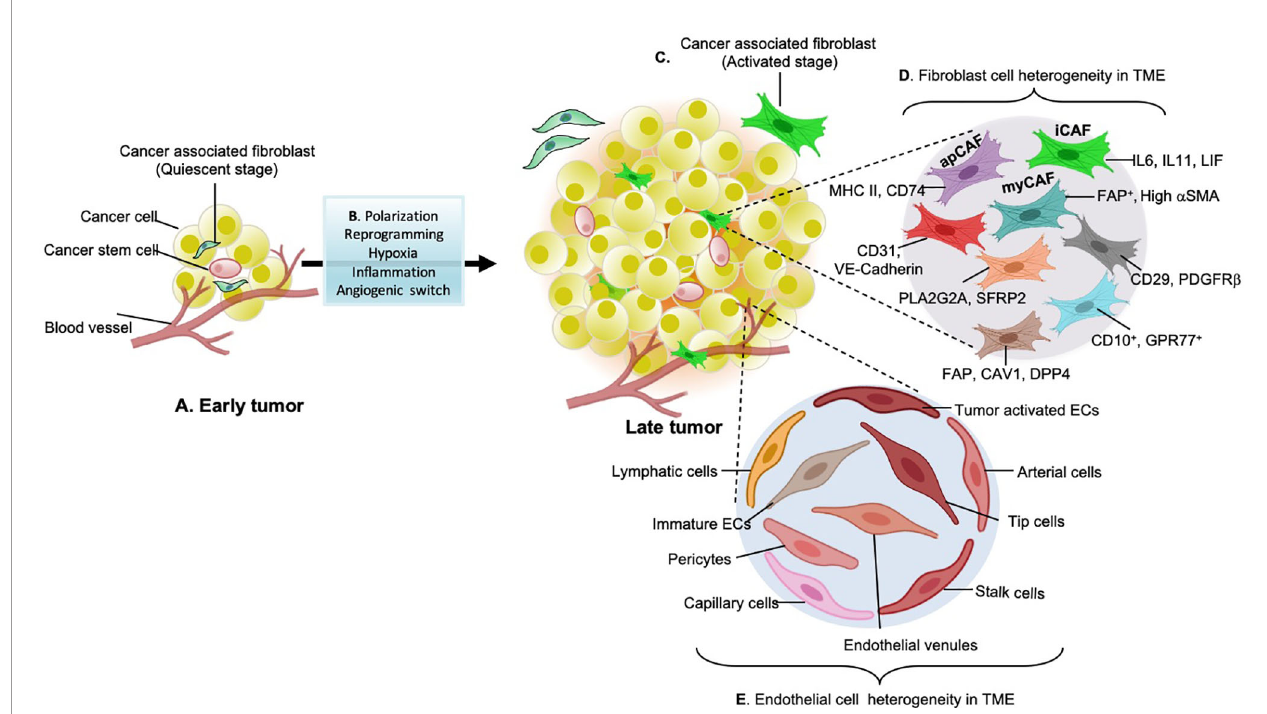
FIGURE 1 | Stromal cell types in early and late-stage tumors. (A) early tumors consist of non-aggressive quiescent fi broblasts in the Tumor microenvironment (TME). (B) Factors such as hypoxia lead to tumor in fl ammation and trigger environmental clues that participate in the paracrine signaling loop (cytokines, chemokines, growth factors) and angiogenic switches (VEGF, PDGF-b, FGF, and EGF) which causes stromal cell polarization or reprogramming. Together all these factors are responsible for the diversi fi cation of stromal cell types during cancer development. (C) Cytokines growth factors such as TGF-b, IL-6 released from tumor cells activate quiescent fi broblasts. (D) Activated fi broblasts further reprogram to secretory phenotypes specialized in ECM remodeling and immuno-modulation. These fi broblasts have enhanced proliferative and matrix secreting (desmoplasia) capabilities. Some of these aggressive cancer-associated fi broblasts (CAF) subtypes found in different types of cancers include antigen-presenting CAFs (apCAFs), in fl ammatory CAFs (iCAFs) and myo fi broblastic CAFs (myCAFs). These subtypes are explored through single-cell RNA sequencing transcriptomics and are named according to the secretory factors and roles which these phenotypes play in the TME. (E) Different types of endothelial cells found in tumor tissues: common endothelial cell types found in core or adjacent tumor areas are known as tumor endothelial cells. Apart from conventional tip and stalk cells, various subpopulations have been identi fi ed that express gene signatures related to the basement membrane breaching (triggering metastasis), immune cell recruitment, and immuno-modulation (causing immunosuppressive TME). Identifying such angiogenic candidates with activated angiogenic transcription factors and enzymes responsible for angiogenesis will be a potential source to develop anti-angiogenic